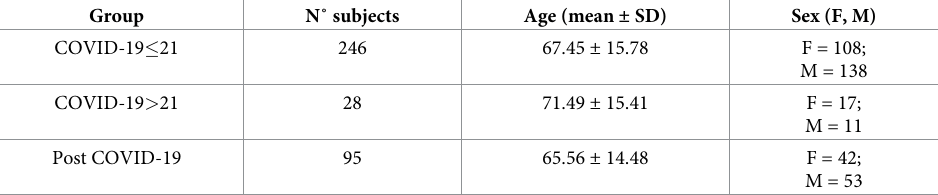
Table 1. EDTA-plasma samples included in the